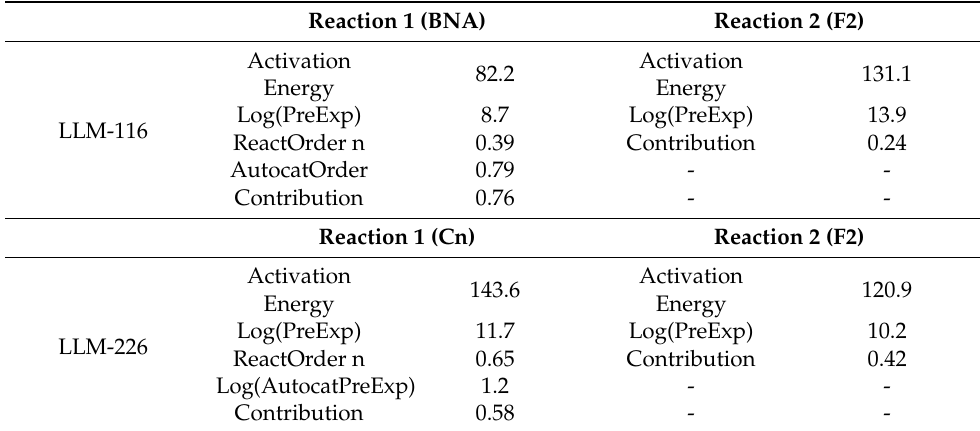
Table 1. Thermal decomposition kinetic parameters of LLM-116 and LLM-226 obtained through multi-step model-fitting